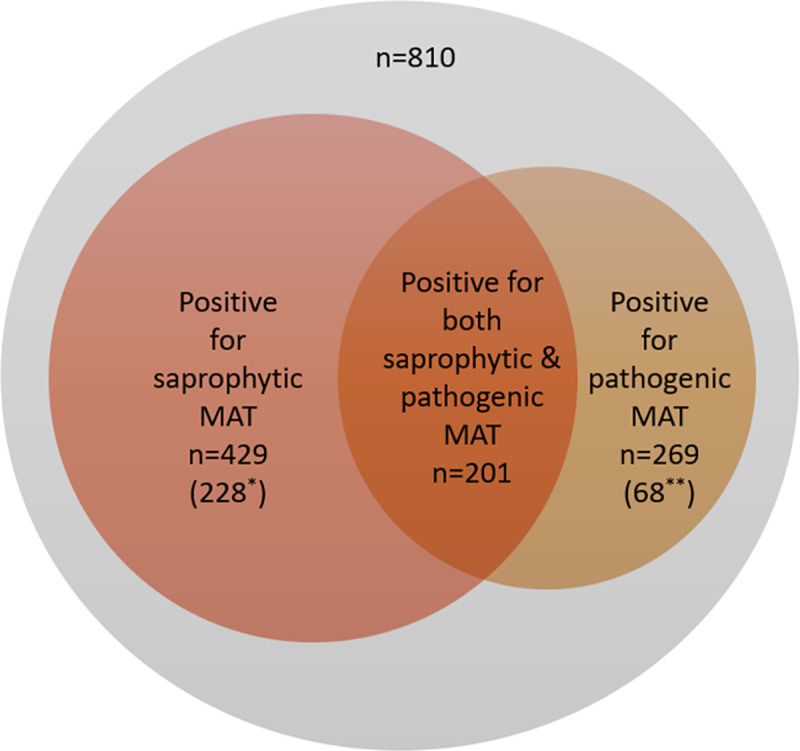
Venn diagram showing MAT positivity based on pathogenic serovar MAT and saprophytic serovar MAT.(*number positive for saprophytic serovar MAT only, **number positive for pathogenic serovar MAT only).